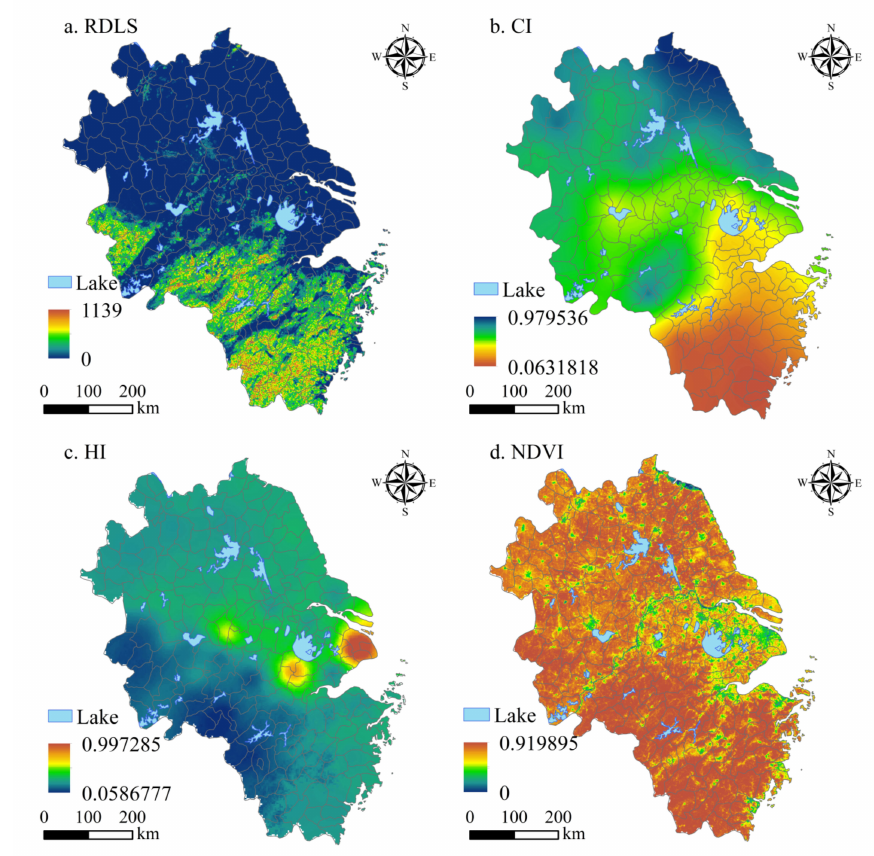
Figure 3. Single-factor spatial distribution of NESI in the